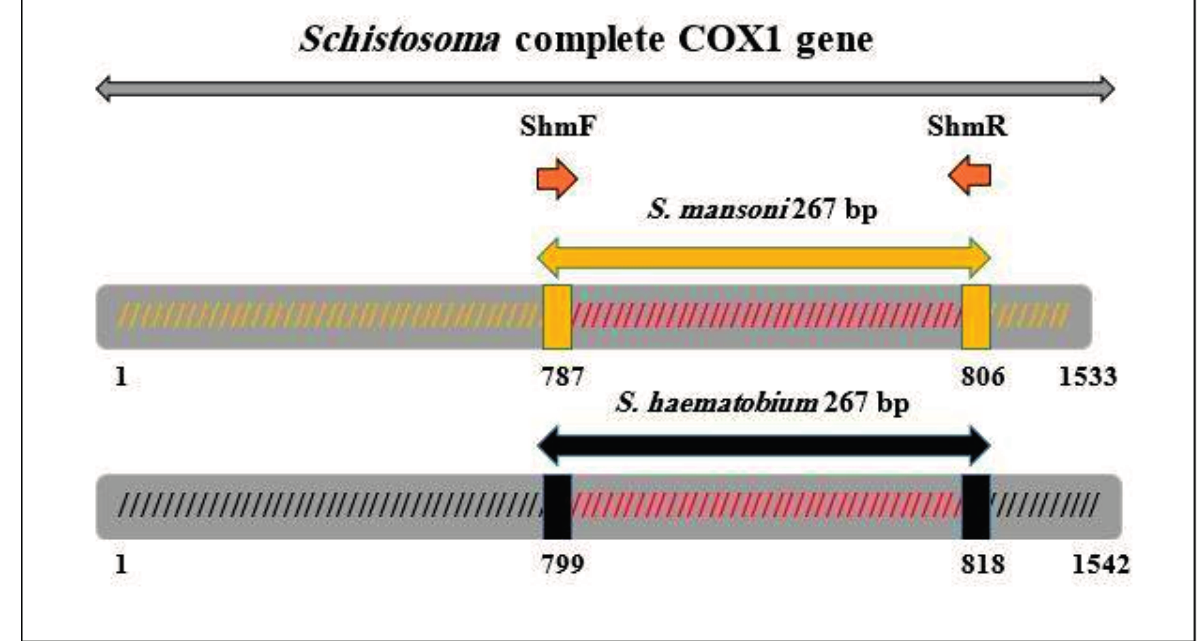
Figure 3. PCR primer sequences and their positions, together with the species PCR fragments in complete cox1